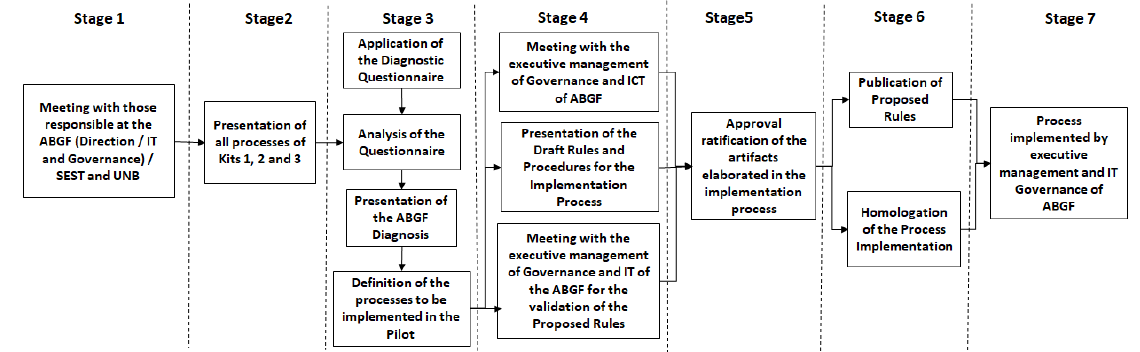
Figure 3. Methodology adopted in the Implementation of the Pilot in the ABGF.